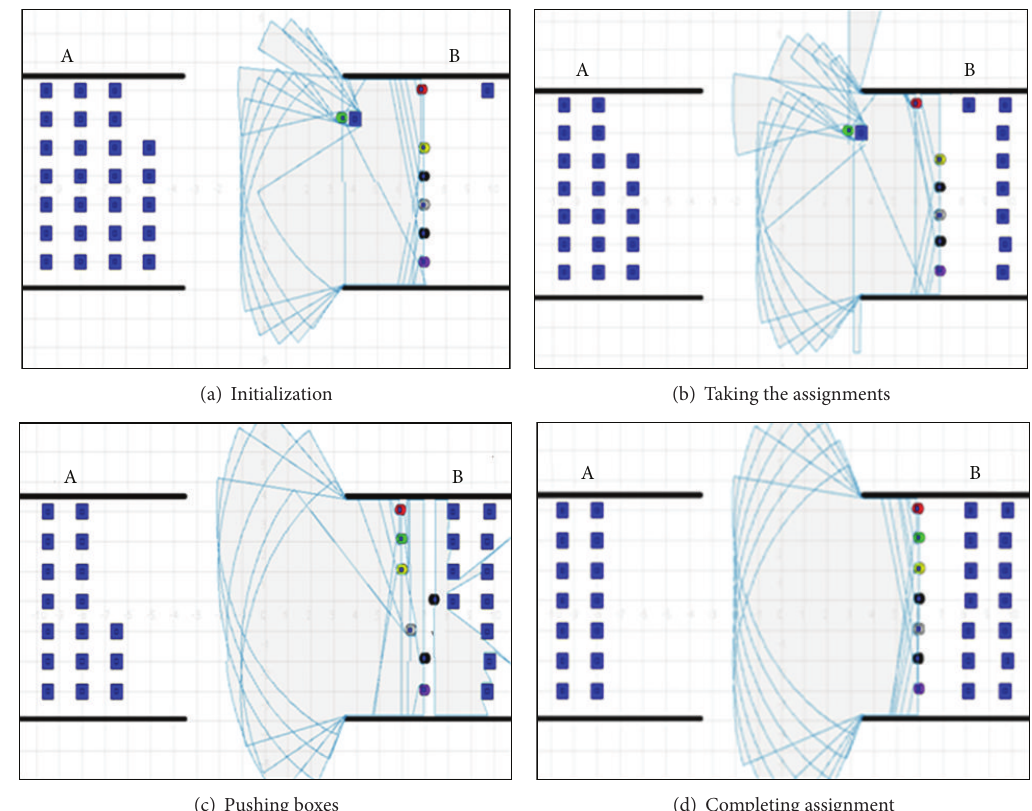
Figure 5: The simulation of sequence allocation.